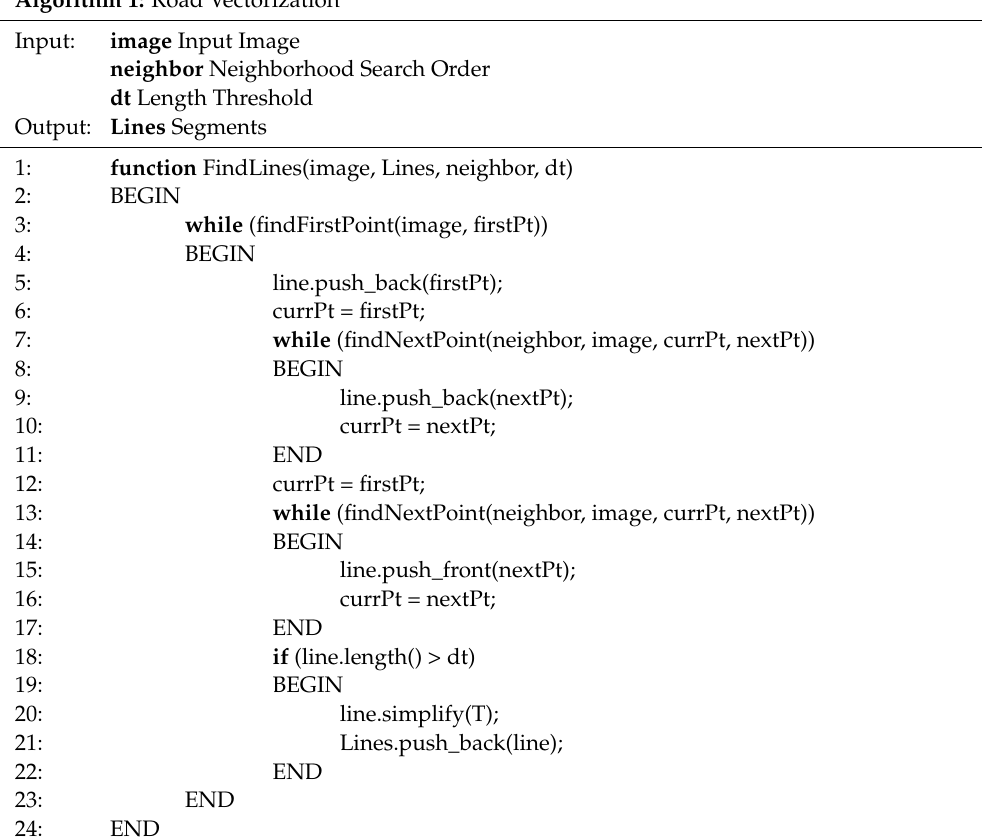
Algorithm 1: Road